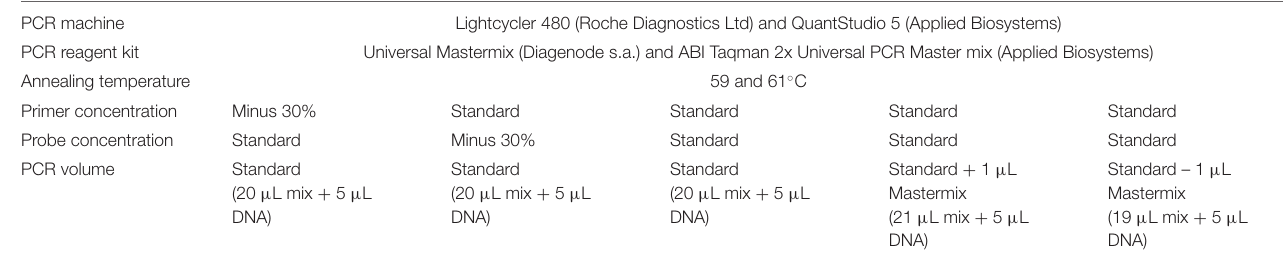
TABLE 3 | Experimental conditions tested to evaluate the robustness of the described Alphitobius diaperinus PCR test. PCR